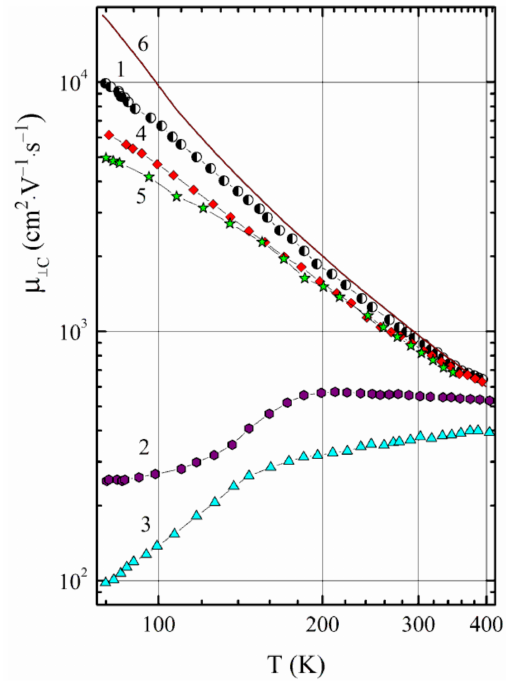
Figure 3. Temperature dependences of the Hall mobility along the layers for the n -InSe samples: pristine (1), first-time and repeatedly intercalated with RbNO 3 (2 and 3, respectively), and annealed in vacuum (4 and 5, respectively). Curve 6 shows drift mobility calculated according to the model in